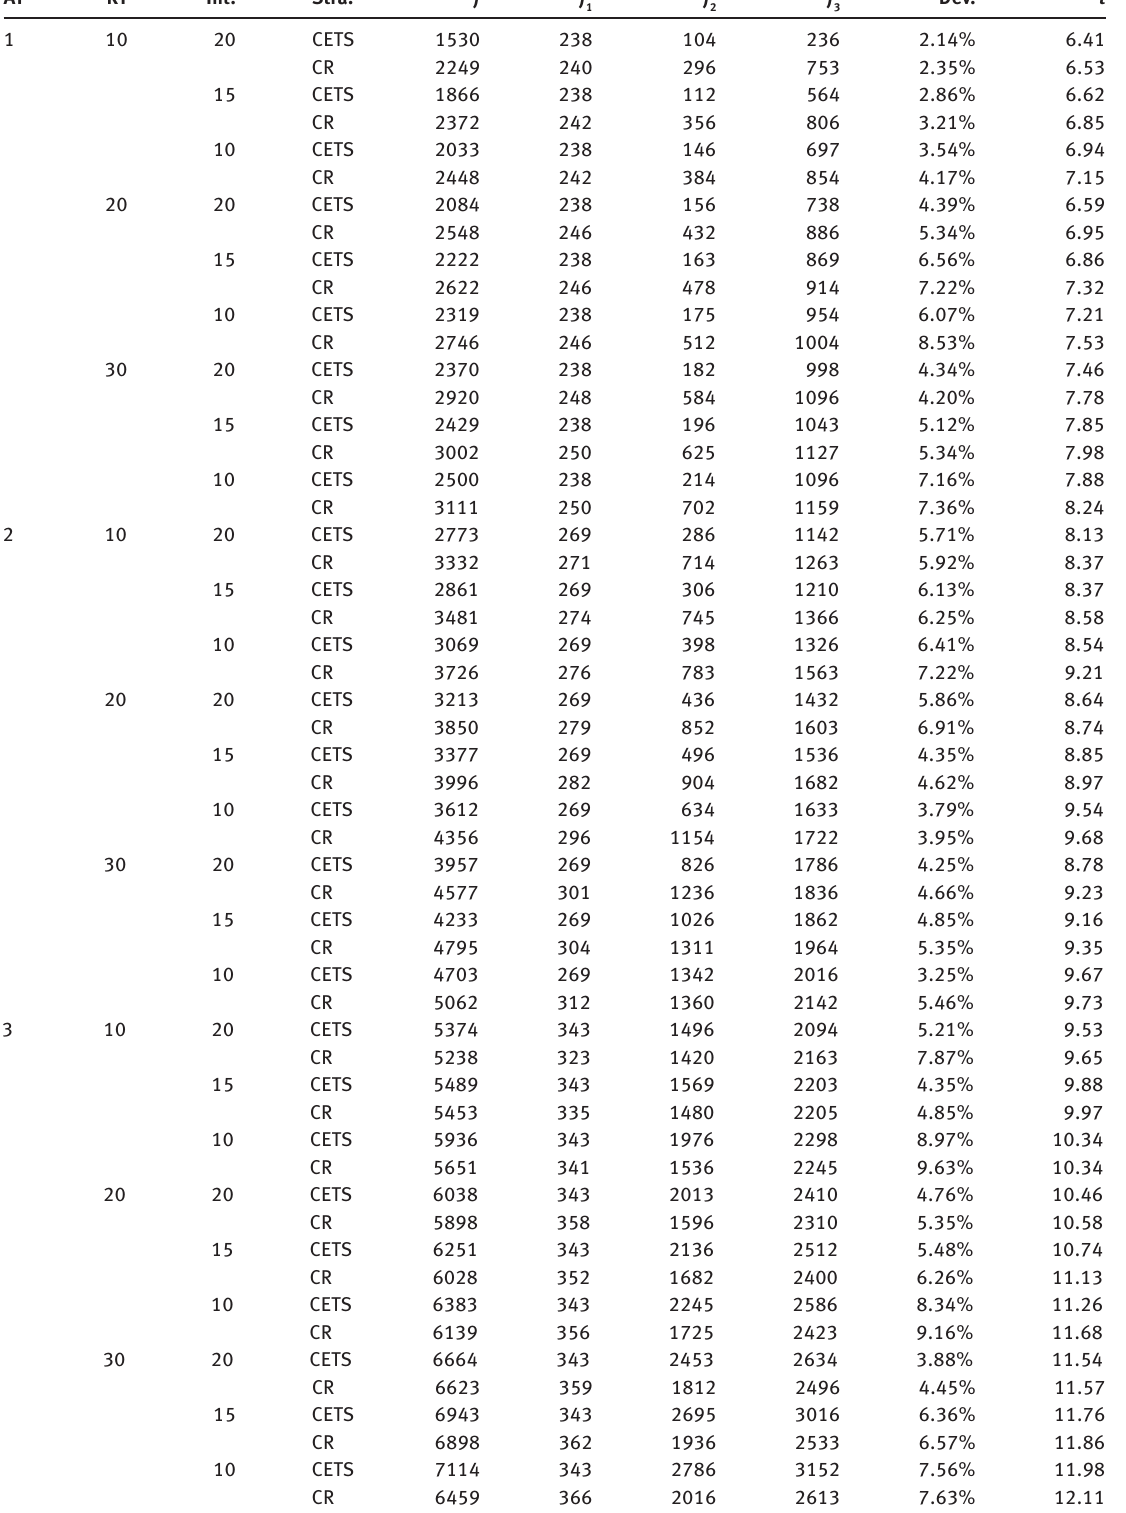
Table 5: Impact of Change Factor on Reallocation Performance. AT RT